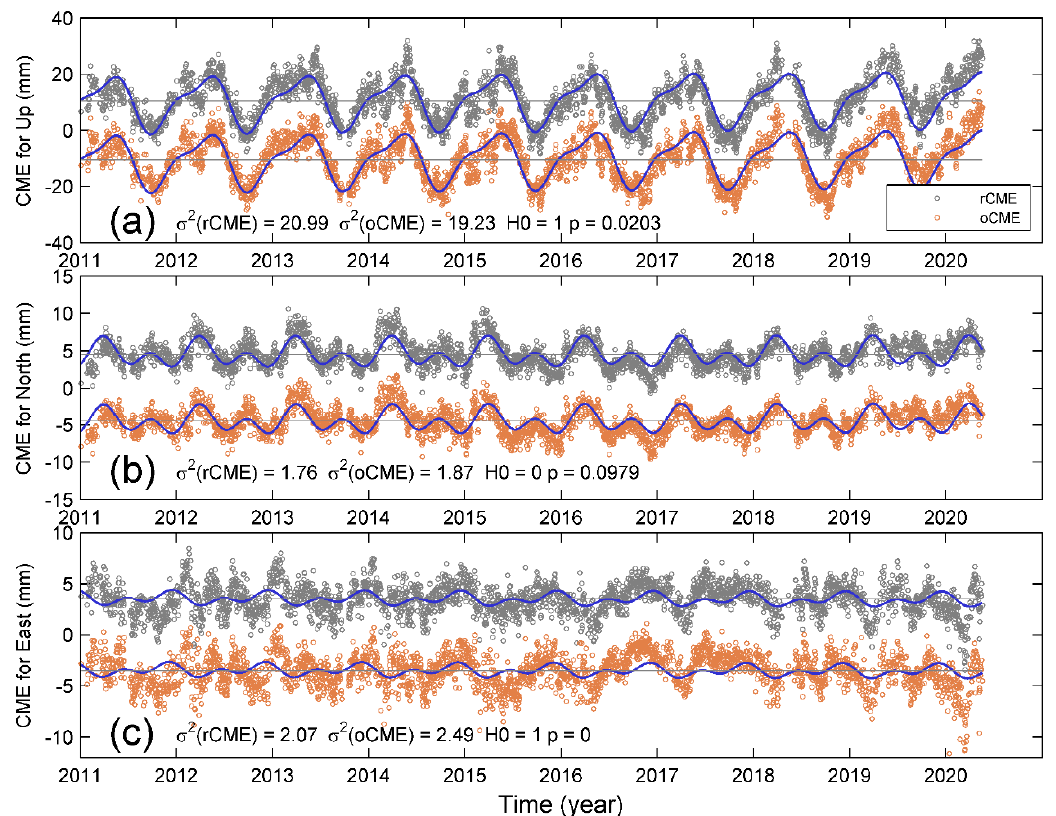
Figure 4. Comparison between three components of oCMEs and rCMEs. Note that offsets of ±3.5, ±4.5, and ±10.5 were added to the oCMEs and rCMEs for ( a ) up, ( b ) north, and ( c ) east components, respectively. The open circles in gray and yellow denote rCME and oCME, respectively. The curves in blue show the modeled annual and semi-annual variations.